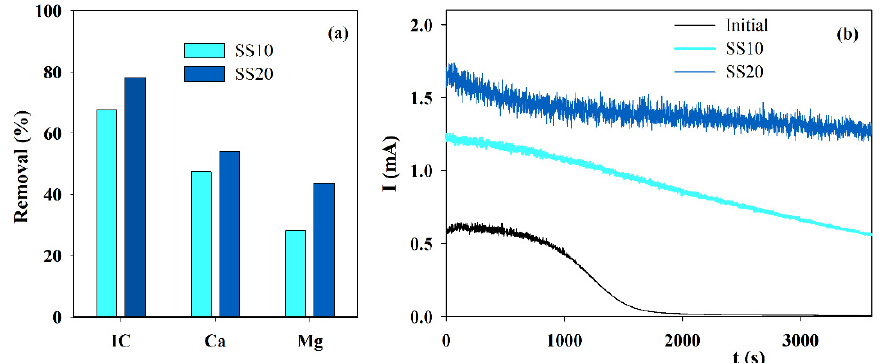
Figure 2. Influence of the cathode area on the ( a ) IC, Ca 2+ and Mg 2+ removals, during electrolysis (I = 0.1 A; Anode—BDD 20 cm 2 ; Cathode—SS, 10 or 20 cm 2 ; Stirring speed—1000 rpm; 4 h), and ( b ) chronoamperometric tests (E = − 0.96 V vs. Ag/AgCl) run with S solution, before and after the electrolytic assays performed using different cathode areas.